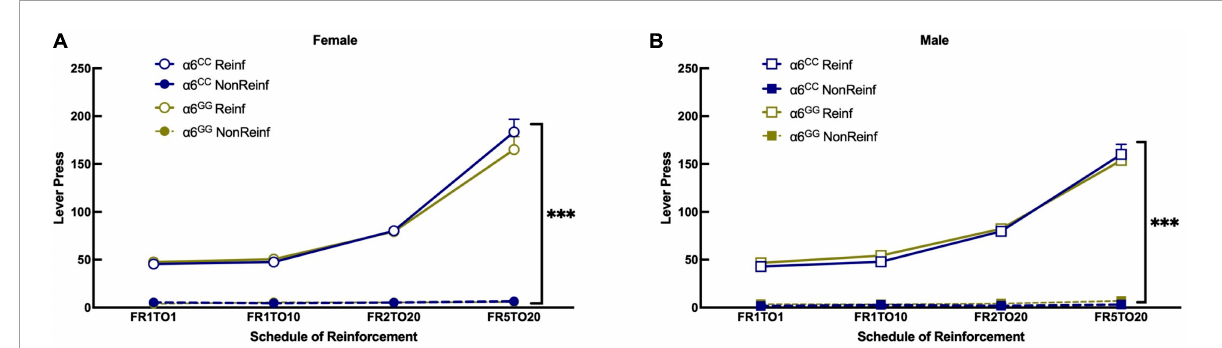
FIGURE2 The human CHRNA 6 3 (cid:48) -UTR SNP knock-in does not impact food self-administration. Female (A) and male (B) , α 6 CC and α 6 GG , mean daily 30 min responses ± SEM for food self-administration at Fixed Ratio (FR)1 Time out (TO)1, FR2TO10, FR2TO20, FR5TO20 schedules of